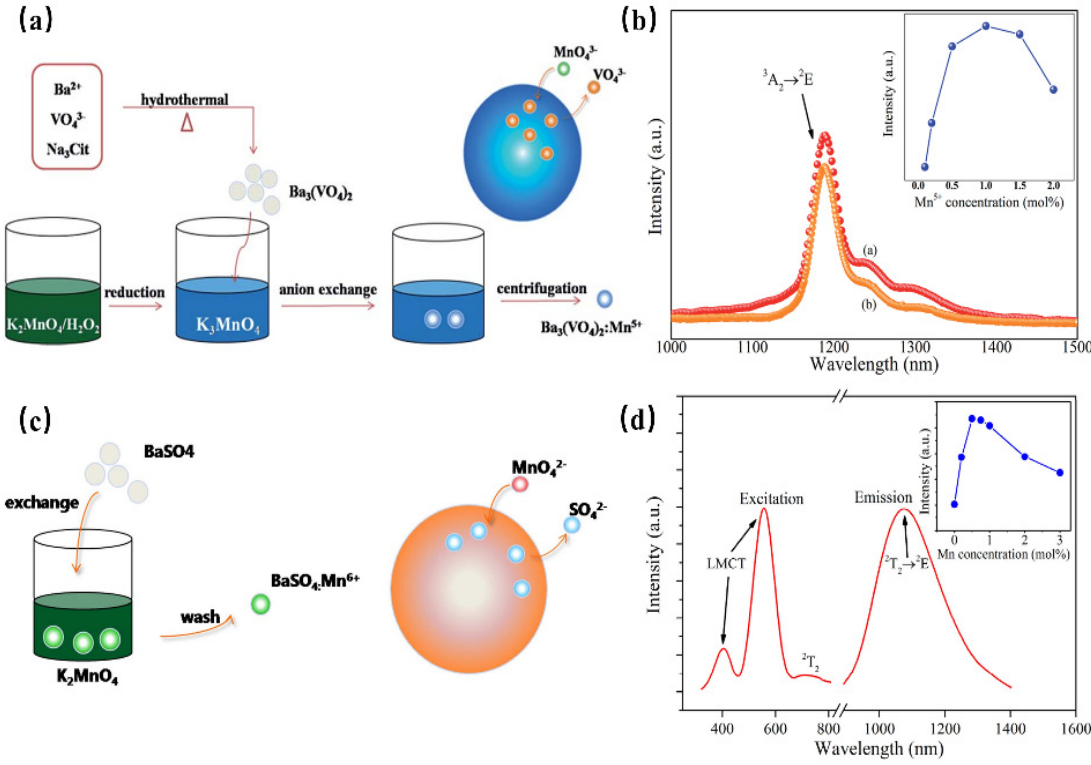
Figure 14. ( a ) Schematic illustration of anion exchange procedure for synthesizing Mn 5+ -doped Ba 3 (VO 4 ) 2 [69]. ( b ) NIR emission spectra of Ba 3 (MO 4 ) 2 : Mn 5+ (M = V, P) phosphors under 808 nm excitation. Inset: concentration dependence of NIR emission intensity of Ba 3 (VO 4 ) 2 : Mn 5+ phosphor (Em = 1190 nm). ( c ) Schematic illustration of anion exchange procedure for the synthesis of BaSO 4 :Mn 6+ . ( d ) PLE and PL spectra of BaSO 4 :Mn 6+ (Ex = 532 nm and Em = 1070 nm).